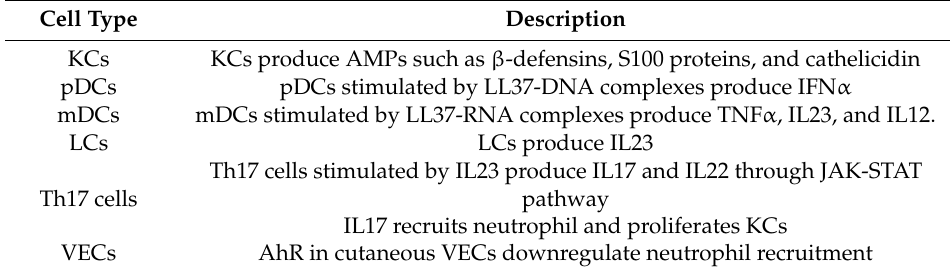
Table 1. Summary of pathogenesis of psoriasis.